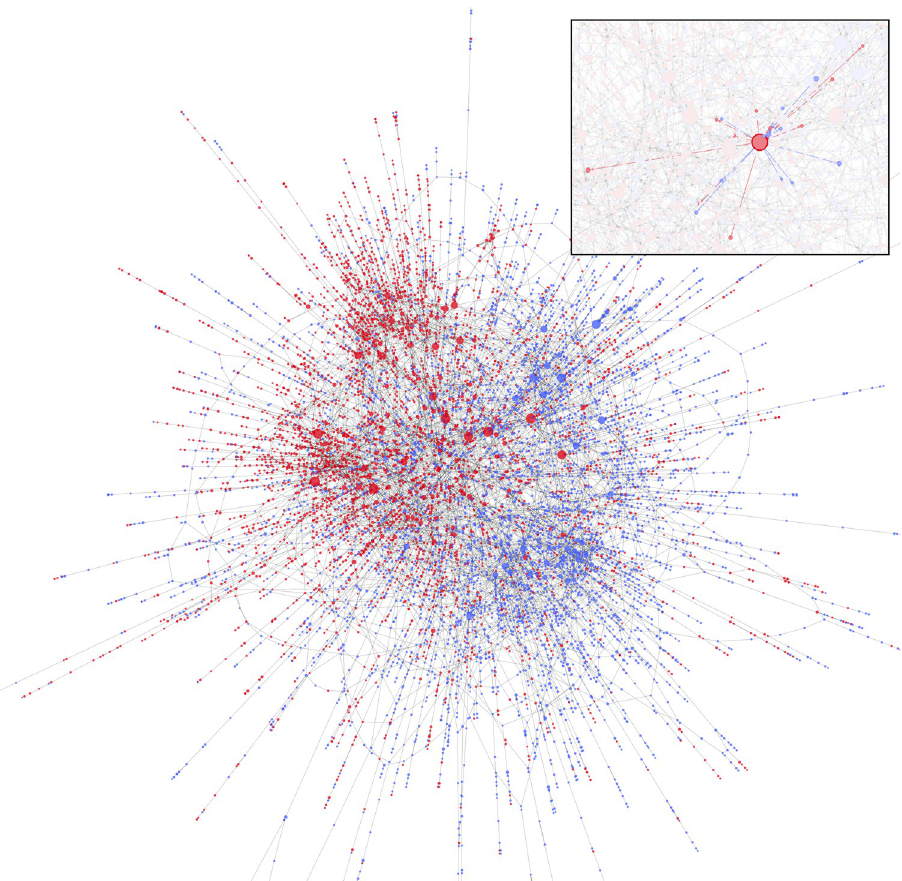
Fig 2. PWID network visualization showing the syringe-sharing relationships between individual PWID in the synthetic population and colored by geographic location: Suburban (red) and urban (blue). The number of individual PWID shown in this figure (9,731) represent 30% of the total PWID population who are part of the most highly connected section of the network and who have more than one network connection. The inset shows a single highlighted PWID and the individuals to who they are directly connected in the syringe-sharing network. Edge colors in the inset represent the locale of the